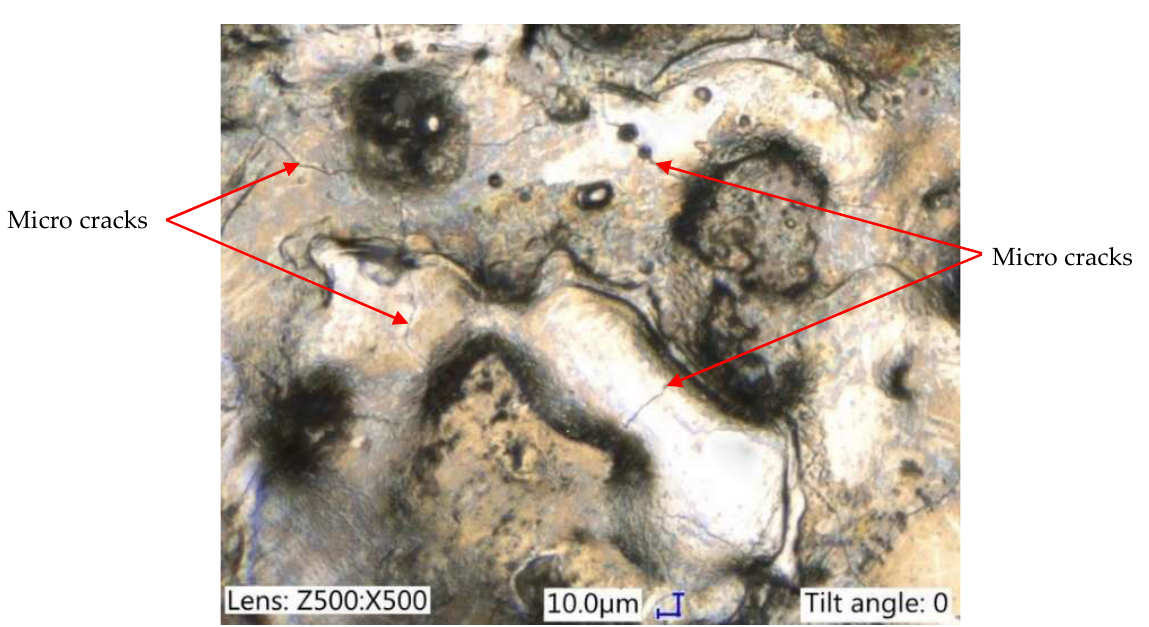
Figure 9. the structure of the surface after EMD: U c = 25 V, I = 14 A, t on = 400 μs, t off = 150 μs. Figure 9. The structure of the surface after EMD: U c = 25 V, I = 14 A, t